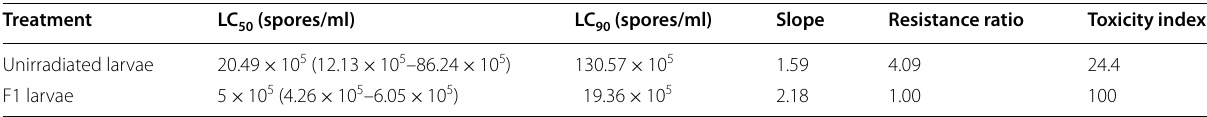
mortality was raised by increasing the fungus concen- tration. The utmost mortality (100%) was recorded after 3 days of larvae feeding on treated leaves with the highest concentration (8 10 5 spores/ml). × Table 2 Median lethal (LC ) and LC values of Metarhizium anisopliae after 2 days of feeding normal and F1 5th instar Agrotis ipsilon 50 90 larvae on treated leaves Treatment